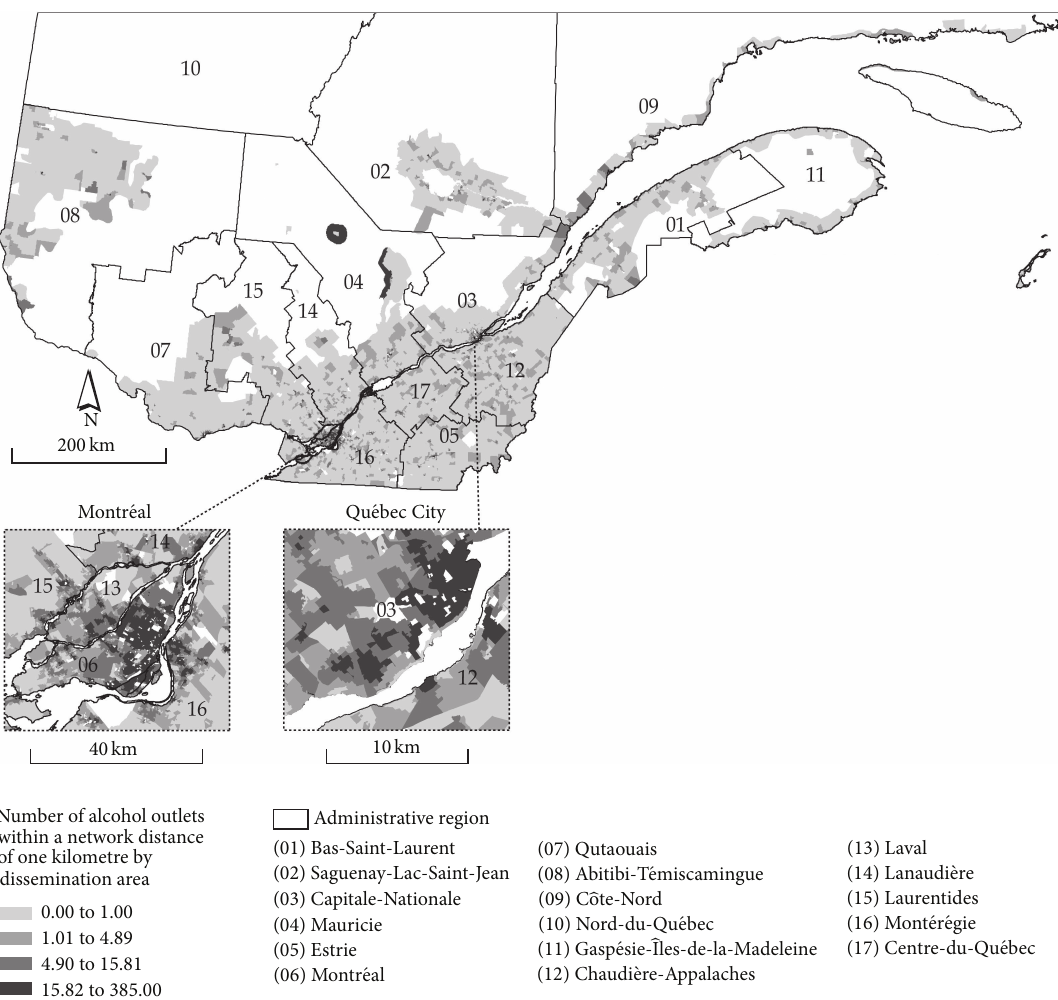
Figure 1: Spatial locations of alcohol outlets in